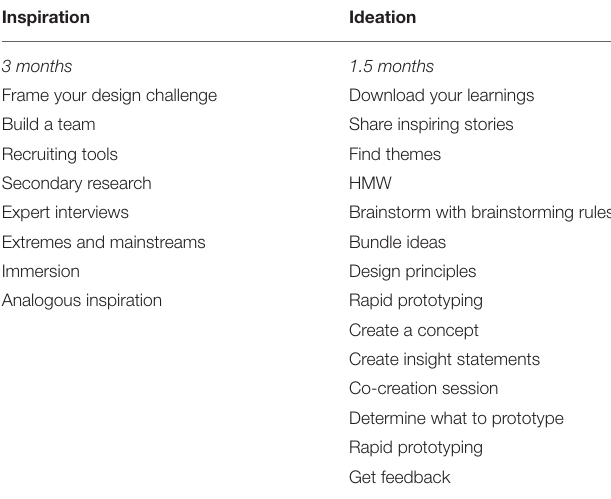
TABLE 1 | Course development process